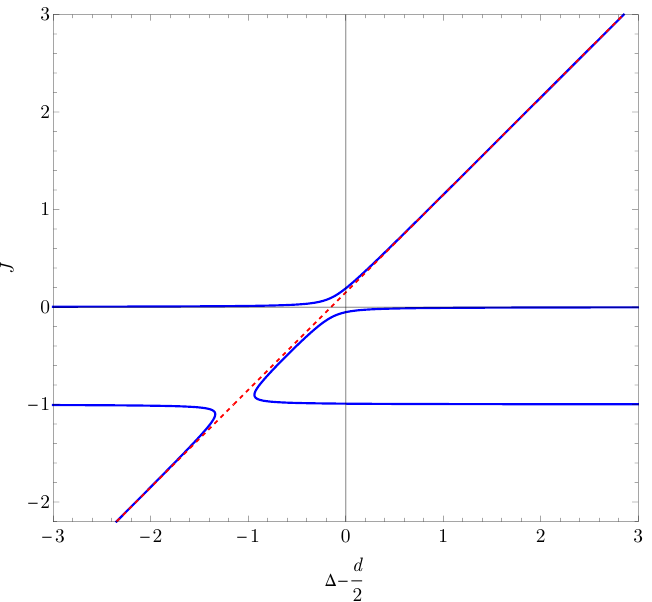
Figure 3. Solid, blue: the naive leading Regge trajectory in Wilson-Fisher theory at O ( (cid:15) 2 ) . Dashed, red: the same trajectory in free theory. The plot is made for (cid:15) = 0 . 3 . The correct picture will be more complex, as described in the main text (see also figures 5 and